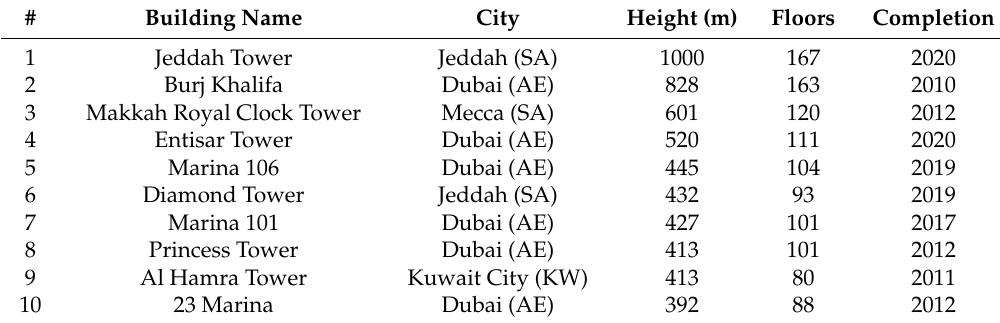
Table 5. The Middle East’s 10 tallest skyscrapers in 2020.